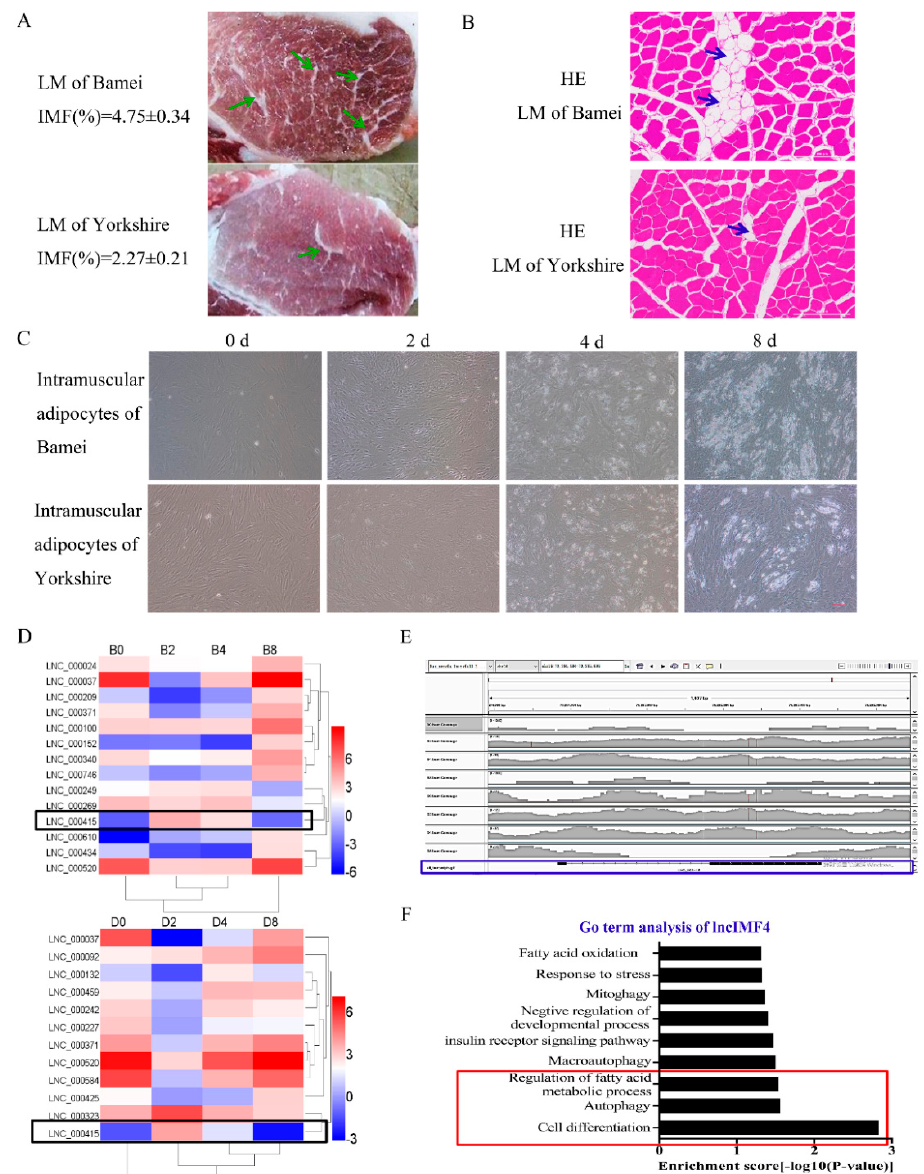
Figure 1. LncIMF4 may be a novel lncRNA implicated in intramuscular adipogenesis. ( A ) The intramuscular fat (IMF) content of longissimus dorsi muscle (LM) between Bamei and Yorkshire were analyzed by Soxhlet extraction method. ( B ) Hematoxylin–eosin (HE) staining of LM between Bamei and Yorkshire. ( C ) Porcine intramuscular adipocytes at 0, 2, 4, and 8 d after inducing differentiation (cell density reached 100%). ( D ) Heatmap depicting long noncoding RNA (lncRNA) having at least 2-fold change in intramuscular adipocytes between fat-type and lean-type pig at four differentiation stages; black fragments denote lncIMF4. ( E ) The alignment track of lncIMF4. ( F ) GO term of lncIMF4. The results were representative of means ± SEM of three independent experiments.